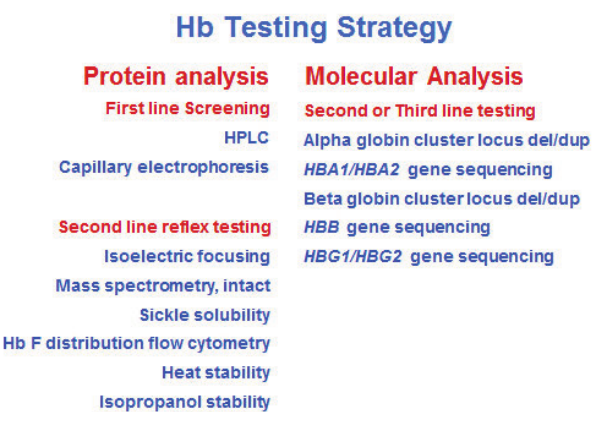
Figure 2. Hemoglobin testing strategy in a high throughput testing laboratory in the United States of America. To increase sensitivity, two screening methods are used for all diagnostic assays. Dependent upon the choice of testing ordered, additional methods may be used a frontline screening methods, such as stability studies for hemolysis, p50 assay for erythrocytosis and methemoglobin and sulfhemoglobin levels for cyanosis. An assay for monitoring previ- ously confirmed hemoglobin disorders may use a single test that reliably separates and quantitates common hemoglobin